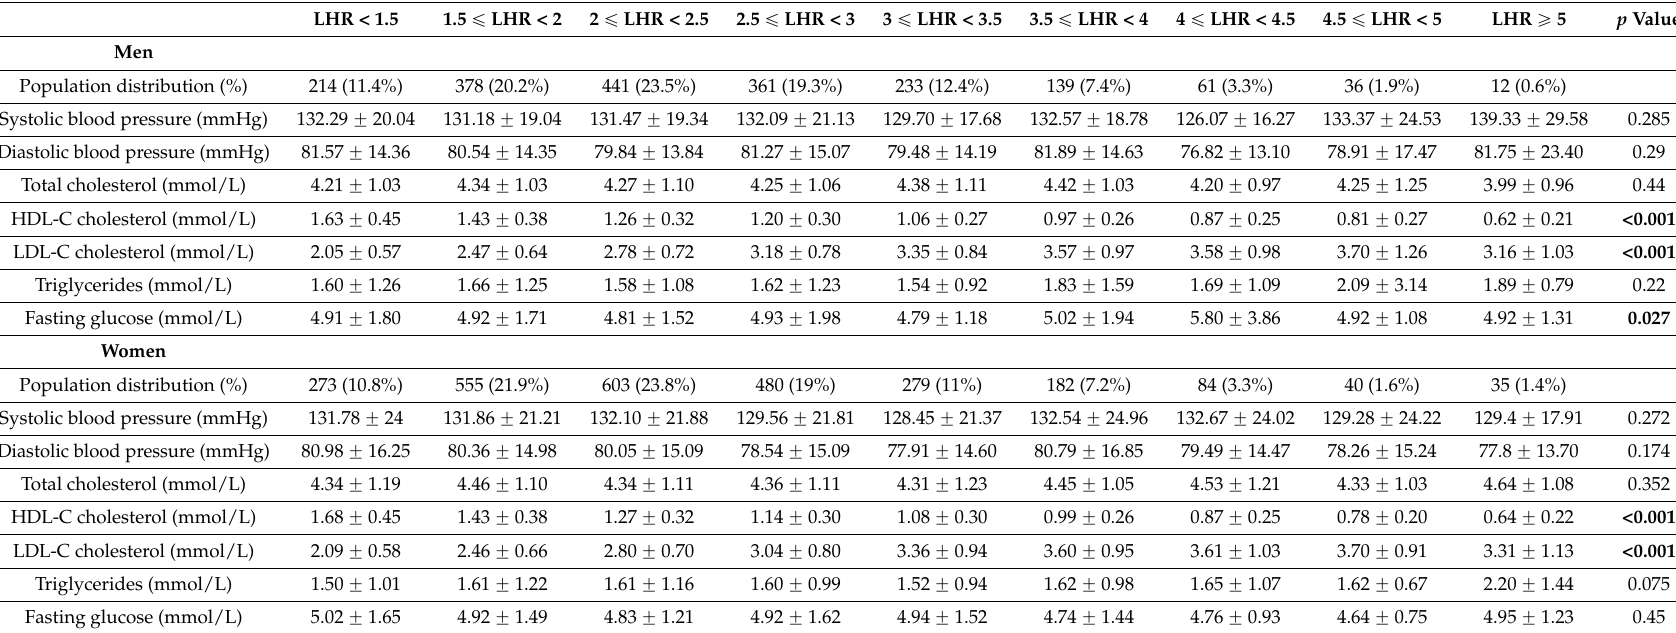
Table 2. Age-standardized CVD risk factors in the Uygur population by LDL-C/HDL-C ratio